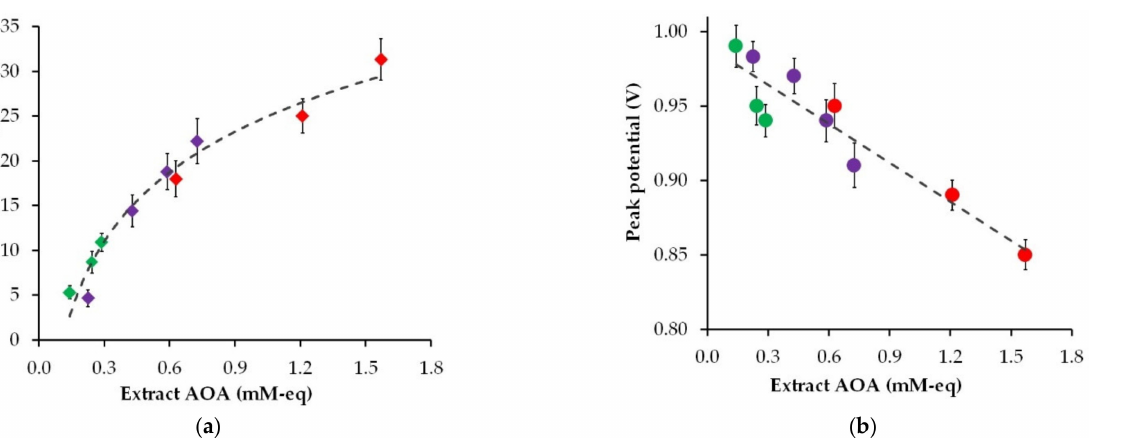
Figure 4. The impact of the AOA of the plant extracts (pH 6) (gooseberry—green marker, black currant—violet marker, and strawberry—red marker) on the peak current ( a ) and the peak potential ( b ) of phyto-AuNPs